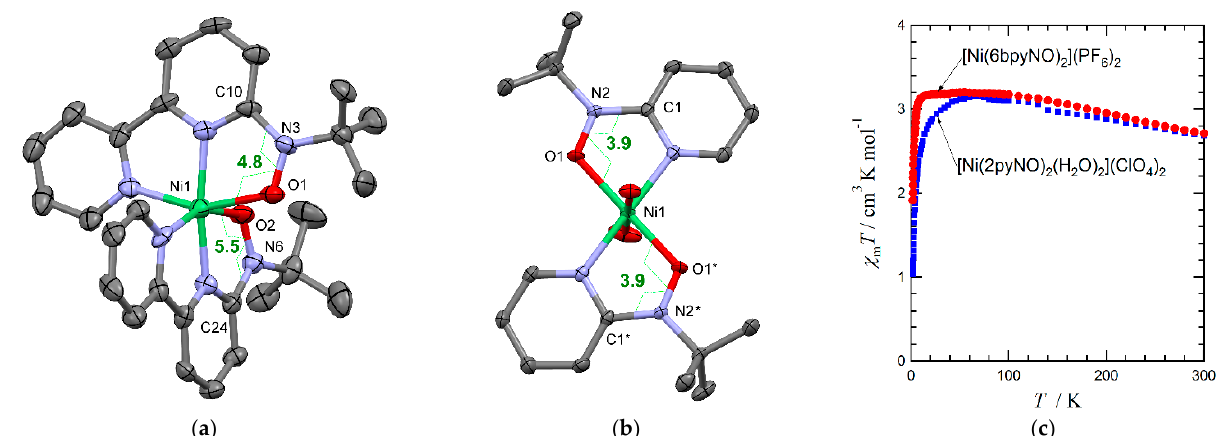
Figure 6. X-ray crystal structures of ( a ) [Ni(6bpyNO) 2 ](PF 6 ) 2 and ( b ) [Ni(2pyNO) 2 (H 2 O) 2 ](ClO 4 ) 2 , measured at 90 and 100 K, respectively. Counter anions and hydrogen atoms are omitted for the sake of clarity. Thermal ellipsoids are drawn at the 50% probability level. Selected atomic numbering and Ni–O–N–C sp 2 torsion angles are indicated. ( c ) Temperature dependence of χ m T for the two compounds. Adapted with permission from [96,97], published by the American Chemical Society, 2006 and 2007.